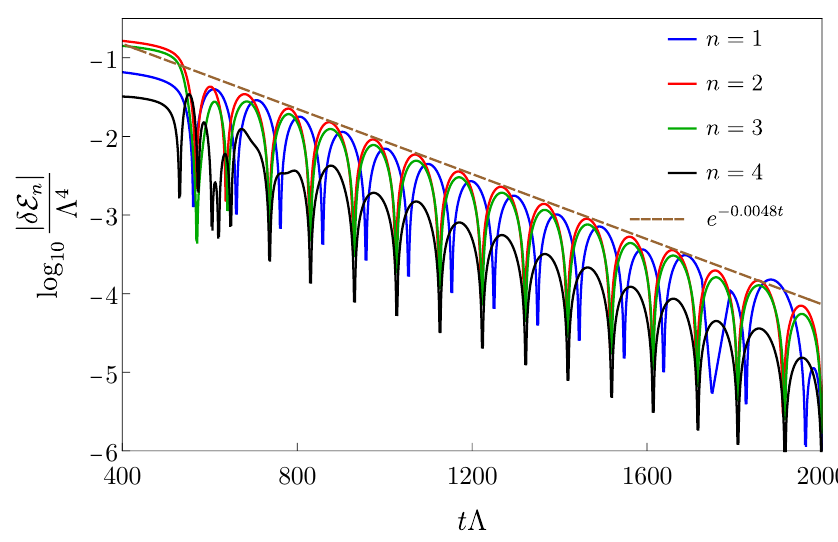
Figure 13 . Time evolution of the spatial Fourier modes of δ E = E ( t, z ) −E eq ( z ) after the merging. All modes evolve as δ E n ∼ exp( ω 1 t ) cos( ω 2 t ) with the same ( ω 1 , ω 2 ) = ( − 0 . 012 , 0 . 063)